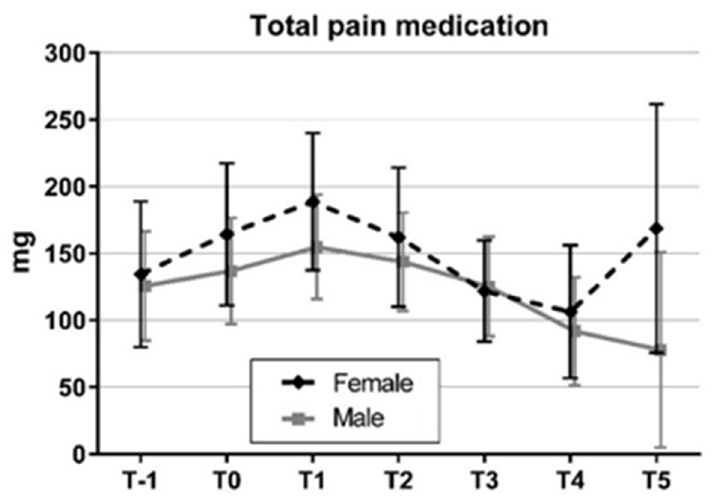
Figure 3. Means and 95% confidence intervals of total pain medication from hospital admission (T- 1) to day 5 (T5) by gender.